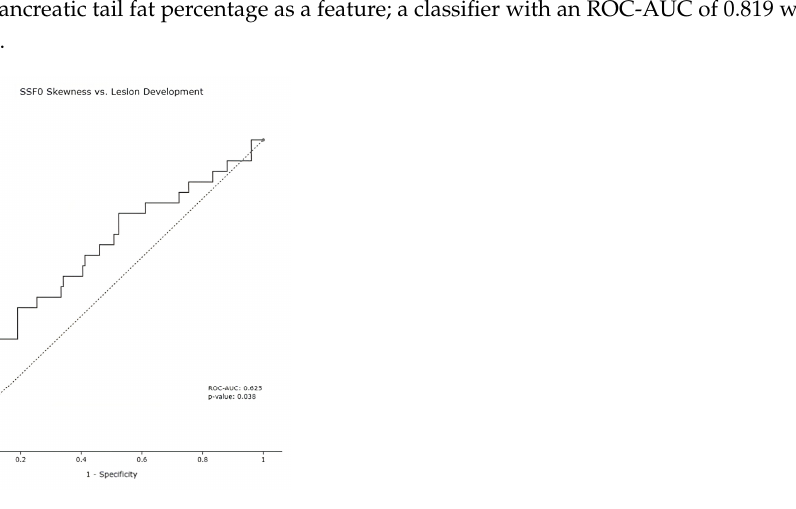
Figure 4. Lesion Skewness ROC Curve. Overall, SSF0 skewness was measurable on 154 pancreatic regions. Skewness measurements at baseline timepoints achieved a 0.625 ROC-AUC when discrim- inating for future lesion development, with a statistical significance of 0.038.